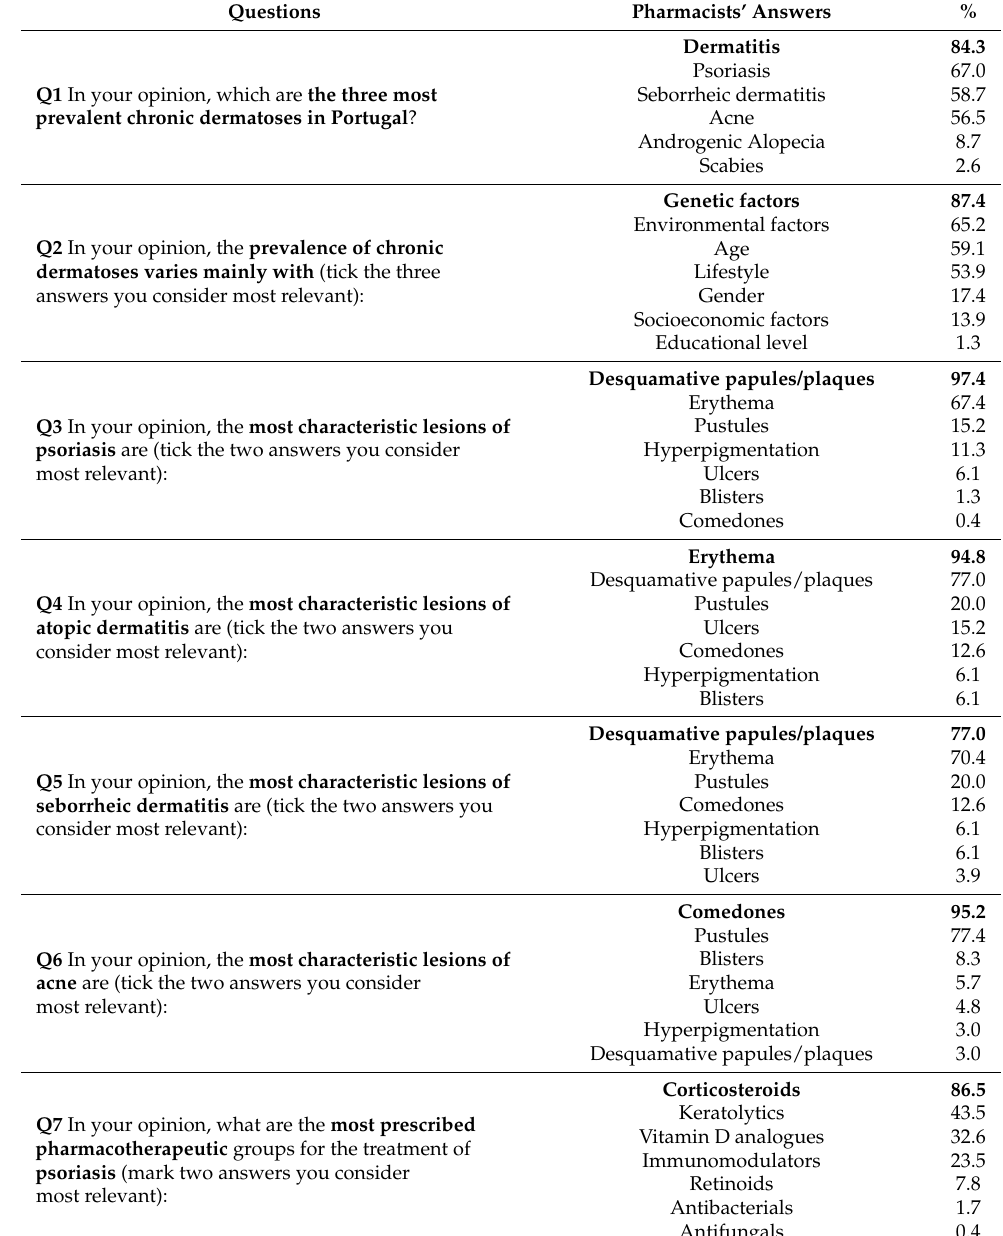
Table 2. Distribution of pharmacists’